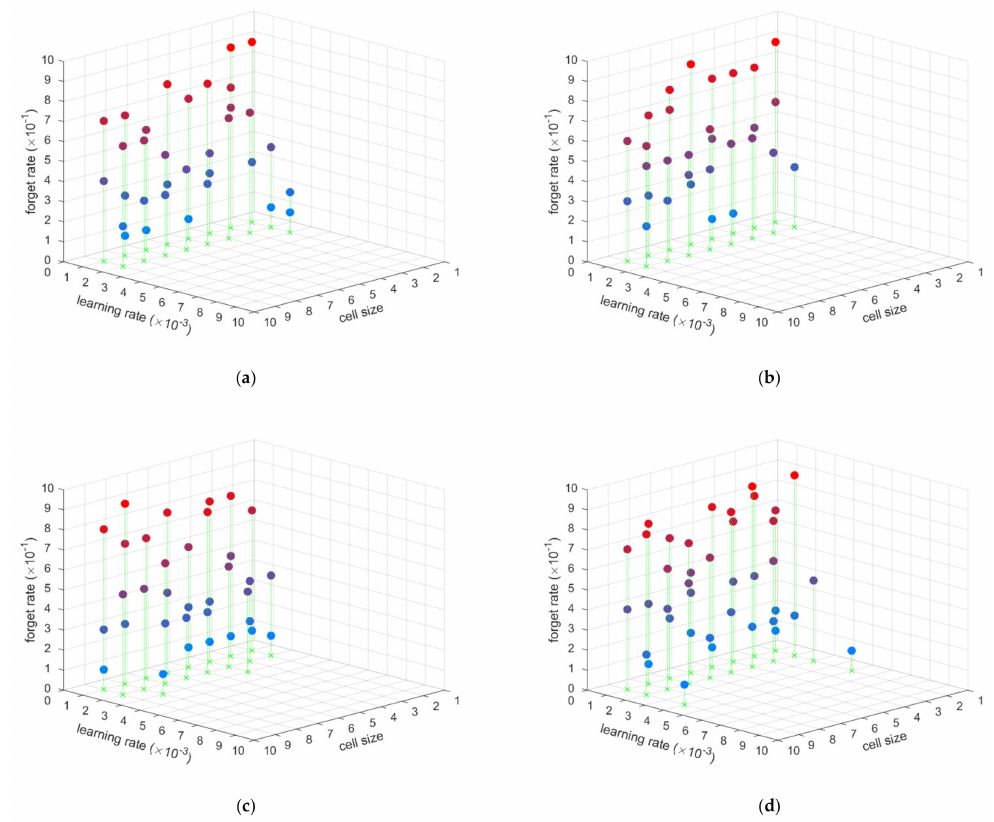
Figure 4. The hyperparameter evaluation for dynamic position estimation: ( a ) batch size is 5, ( b ) batch size is 10, ( c ) batch size is 15, ( d ) batch size is 20.